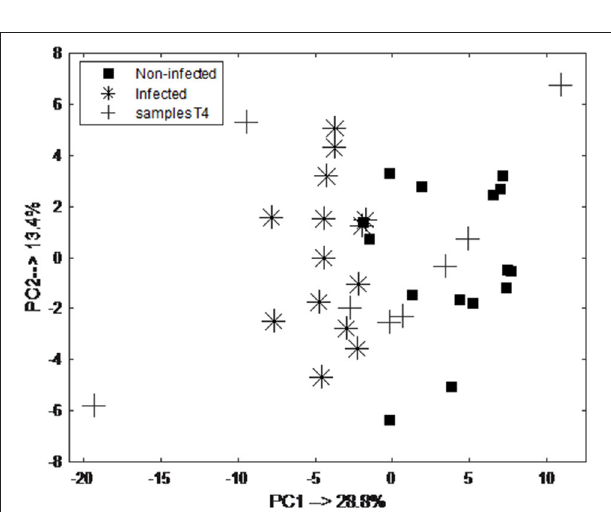
swabs can be used to predict group B streptococcus infection linked to preterm labor (46).